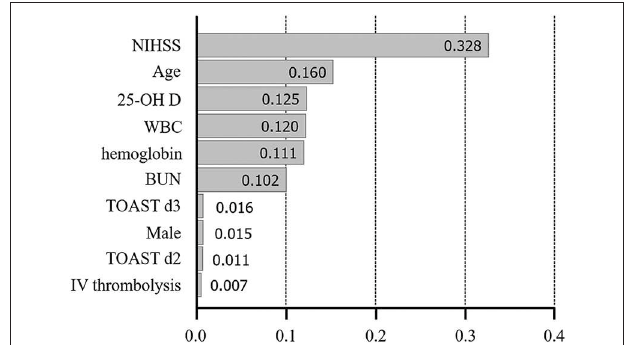
FIGURE 2 | Variable importance plot for XGBoost. NIHSS, National Institute of Health Stroke Scale; 25-OH D, 25-hydroxyvitamin D, WBC, white blood cell; BUN, blood urea nitrogen; TOAST, Trial of Org 10172 in Acute Stroke Treatment; LAA, large artery atherosclerosis; d2-3, 2nd and 3rd dummy variable; IV, intravenous. X-axis represents variable importance in the extreme gradient boosting prediction.